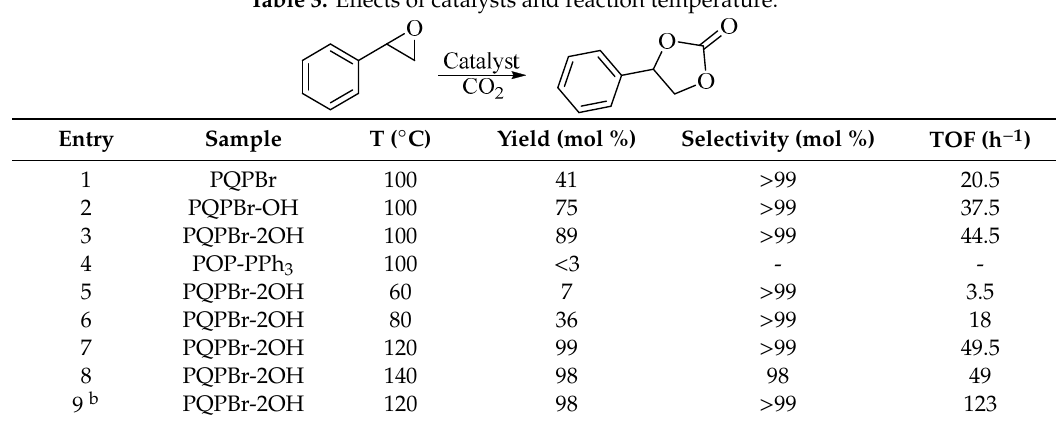
Table 4. Cycloaddition of CO 2 with various epoxides using PQPBr-2OH as a catalyst. a.